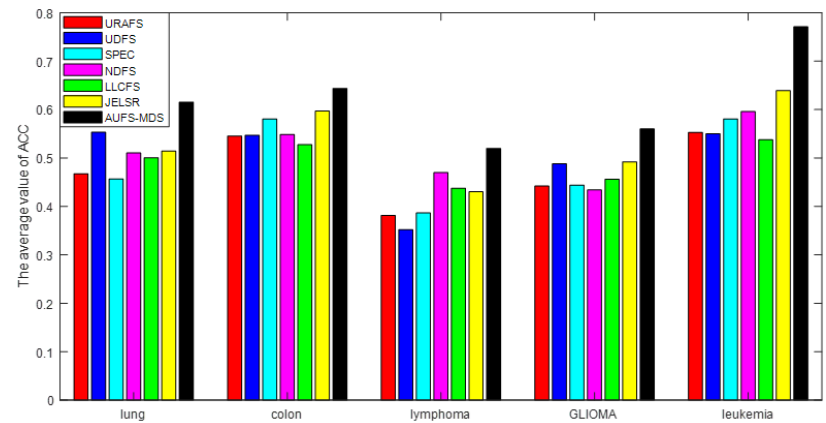
Figure 3. The average ACC of all the methods for five different